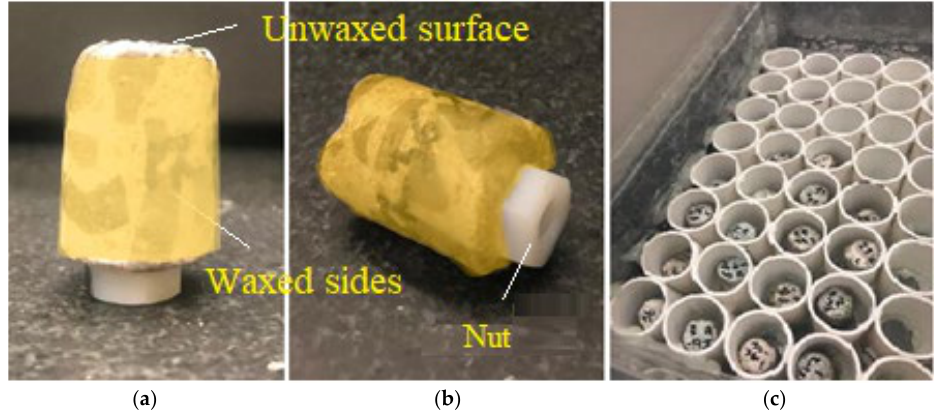
Figure 3. Concrete sample figuration: ( a ) waxed sample, ( b ) nut is glued, and ( c ) samples submerged in the potassium iodide (KI) solution.